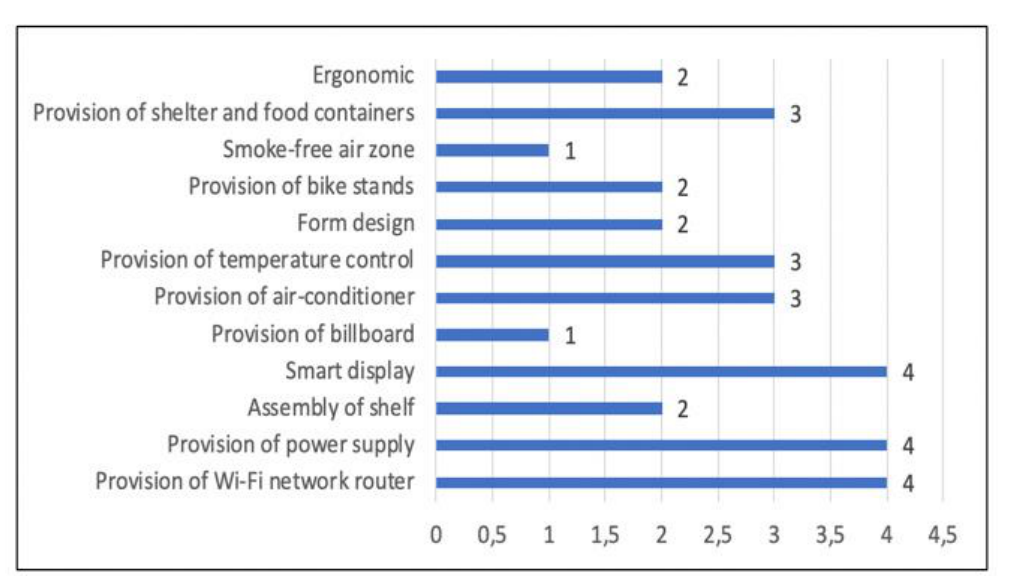
Figure 4. The preferable scatter diagram of Quality Function Deployment (QFD) according to user